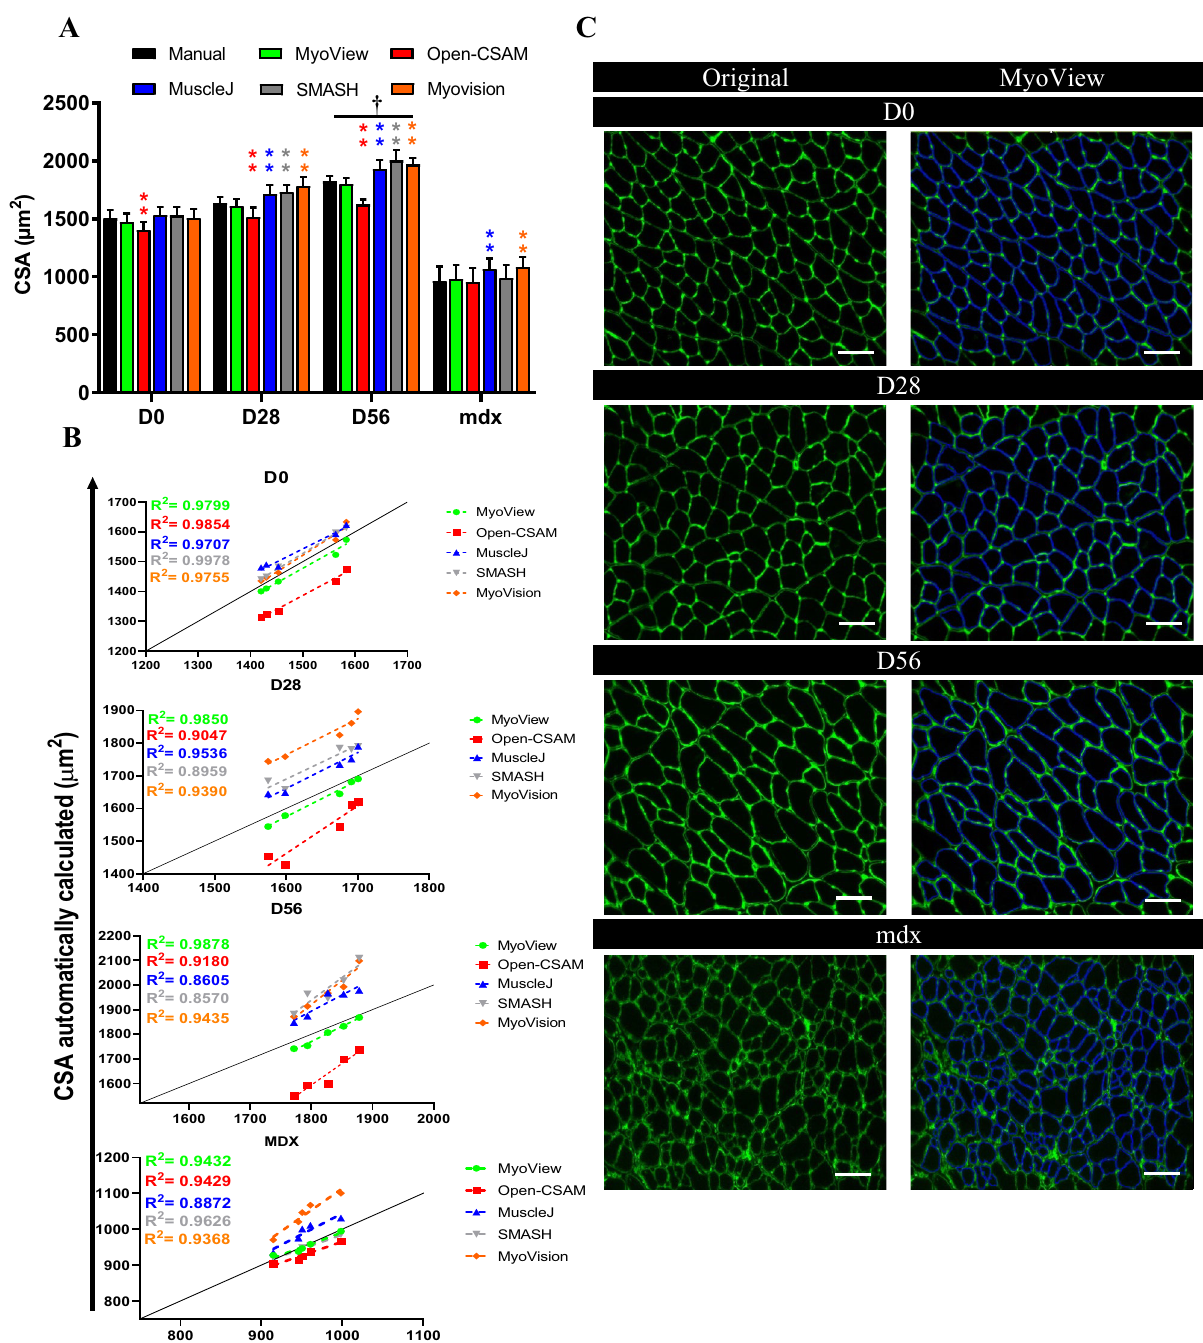
Figure 3. MyoView comparison with Open-CSAM, MuscleJ, SMASH, and MyoVision softwares. The same pictures were analyzed either by manual measurement or using MyoView, Open-CSAM, MuscleJ, SMASH, and MyoVision softwares. ( A ) Mean cross-section area (CSA) obtained on various gastrocnemius muscles. Muscles were isolated from 16- to 18-week-old C57BL/6 mice in (D0) or 28 days (D28), and 56 days (D56) post-HIIT program, and from dystrophic mice (mdx). Results are mean ± SEM of 10 images from 5 muscles in each conditions. ( B ) Correlation between manual measurement (X axis) and MyoView, Open-CSAM, MuscleJ, SMASH, and MyoVision softwares (Y axis) measurements performed on the same images used in ( A ). ( C ) Representative images measured by MyoView on days 0, 28, and 56 post-HIIT program, and from dystrophic mice (mdx). Bars = 25 μm. ** P < 0.01 as compared with manual quantification. Image analysis was performed using Open-CSAM 4 , MuscleJ 6 , SMASH7, and MyoVision 8 softwares. † P < 0.05 as compared with